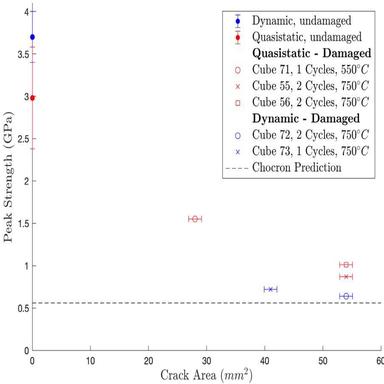
Strength vs. crack area for quasistatic and dynamic tests on damaged material. The vertical error bars for the points at zero crack area show the ranges that would be expected for pristine material in the dynamic and quasistatic loading cases.